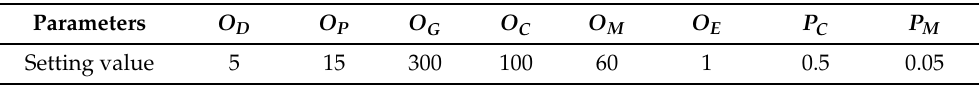
Table 4. Initial setting of GNP